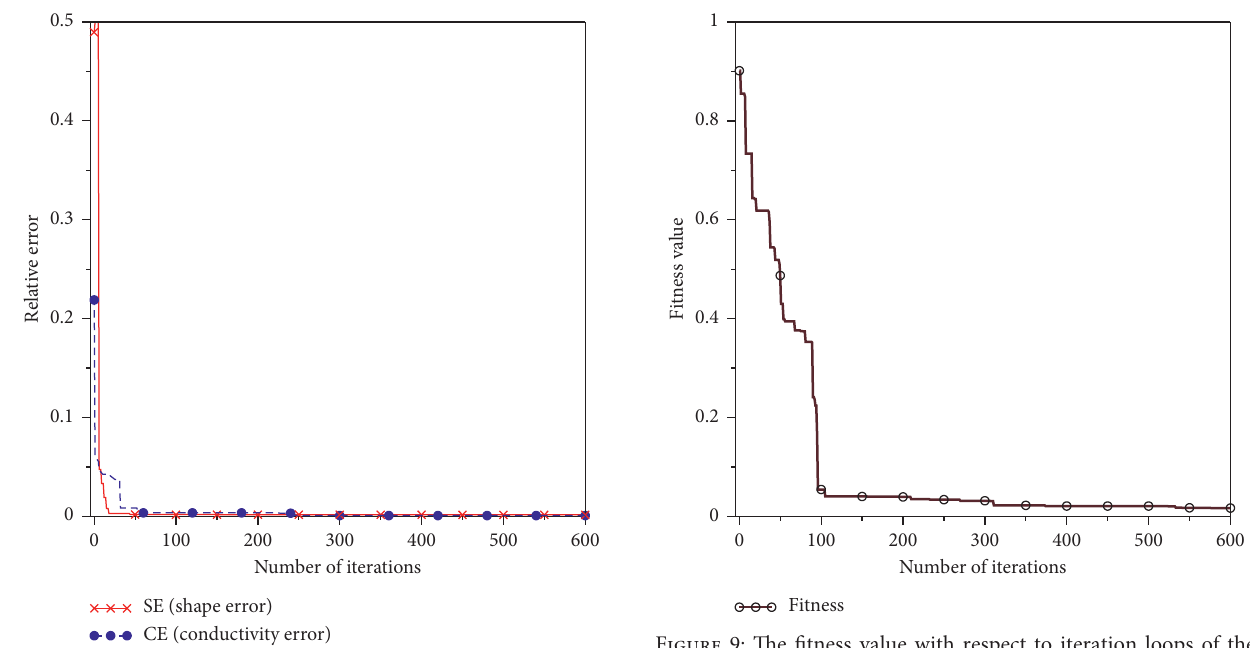
Figure 7: The relative shape and conductivity errors with respect to iteration loopsof the whale optimizationalgorithmfor the first example.